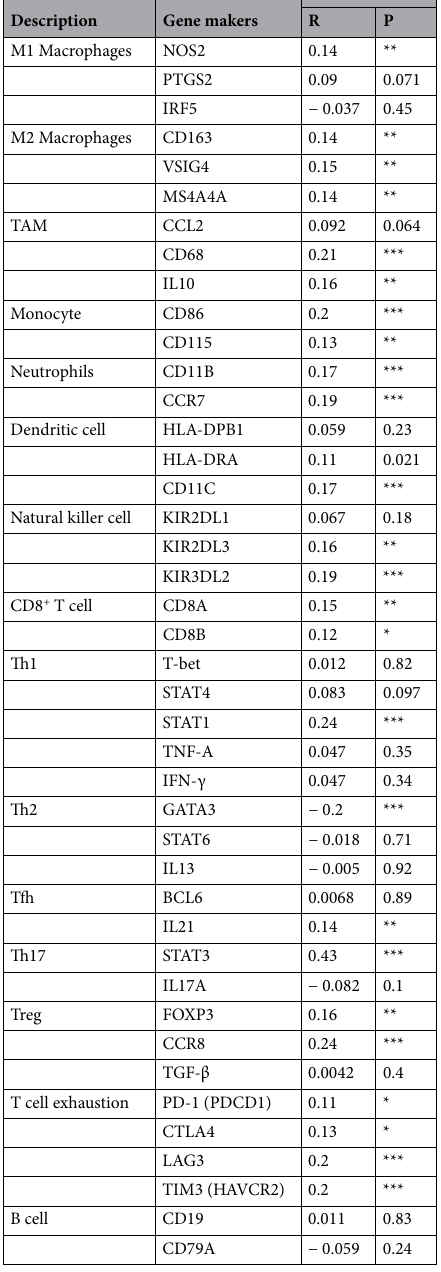
Table 3. Correlation analysis between PRR11 and relate genes of immune cells. * P < 0.05; ** P < 0.01; *** P <